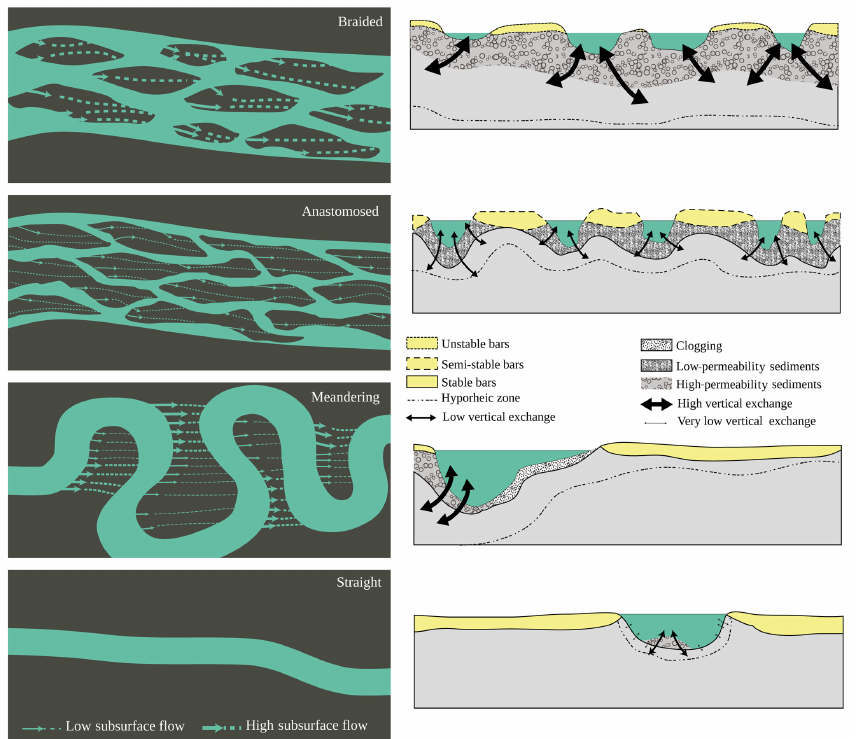
Figure 3. Representation of channel planforms. Sinuosity influences water exchange within a river segment. Hyporheic exchange increases with sinuosity due to hydraulic gradients in the meander neck (Sect.